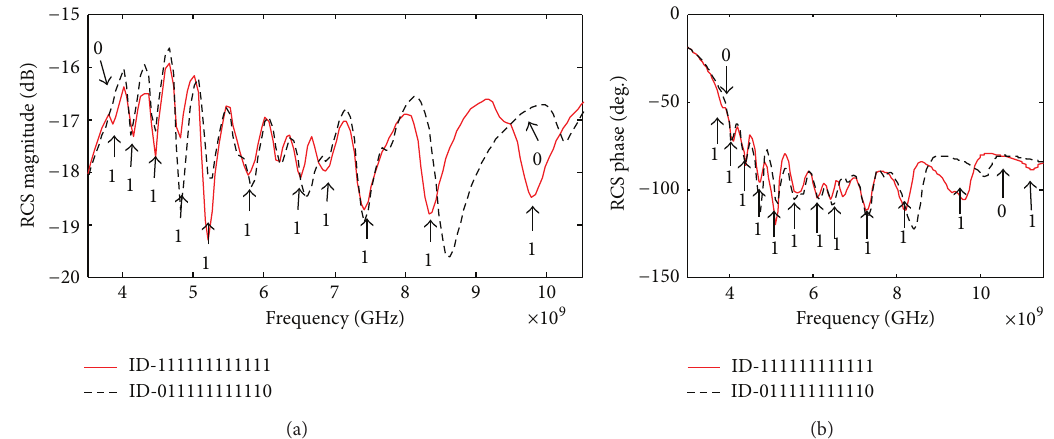
Figure 6: (a) Simulation of magnitude response for tag III and tag IV. (b) Simulation of phase response for tag III and tag IV.